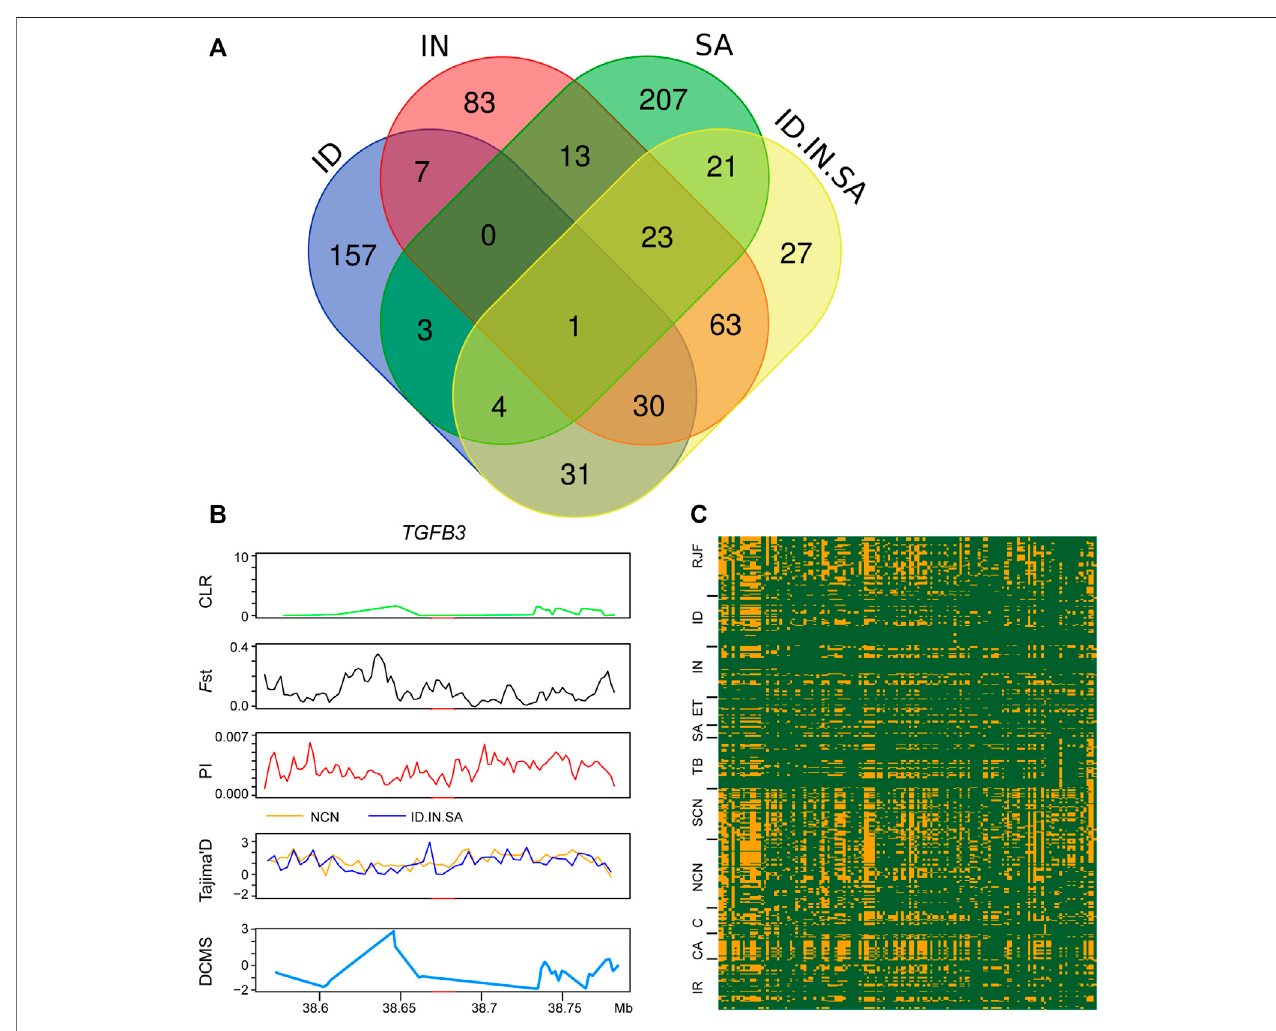
FIGURE 6 | Genomic candidate gene detected XP-EHH analyses of four chicken groups. (A) venn diagram showing the PSGs overlap among XP-EHH ID-to-NCN , XP-EHH IN-to-NCN , XP-EHH SA-to-NCN , and XP-EHH ID.IN.SA-to-NCN . (B) CLR, Fst, π , Tajima ’ sD, and DCMS analysisofTGFB3 identi fi edby XP-EHH analysesoffour chicken